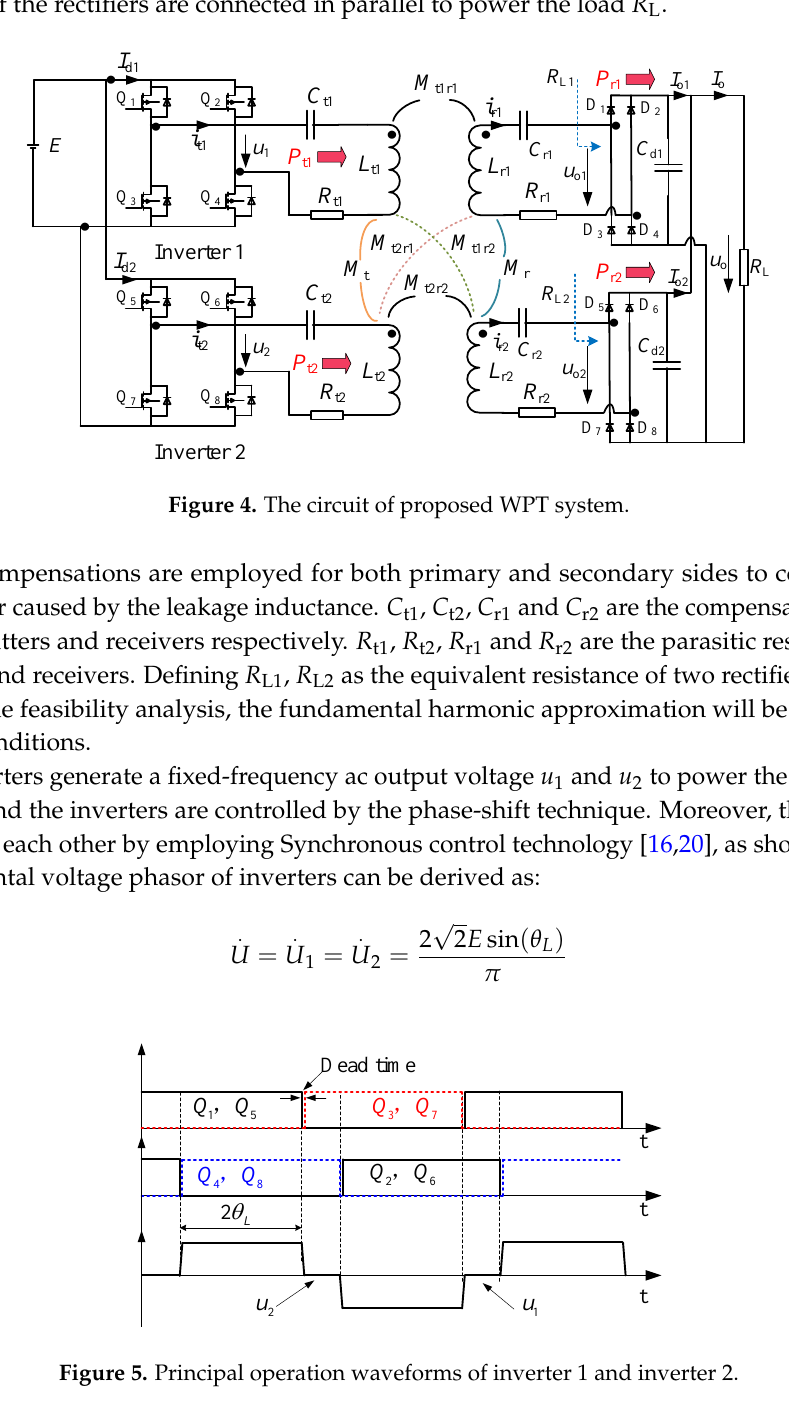
Figure 5. Principal operation waveforms of inverter 1 and inverter 2.